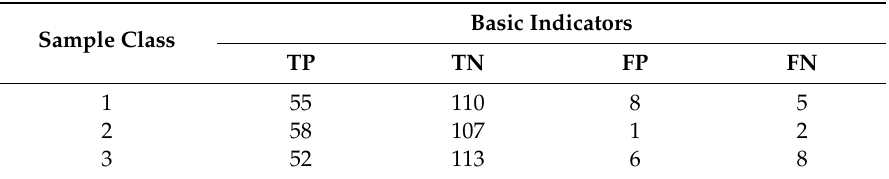
Table 2. Classification results for the SVM.